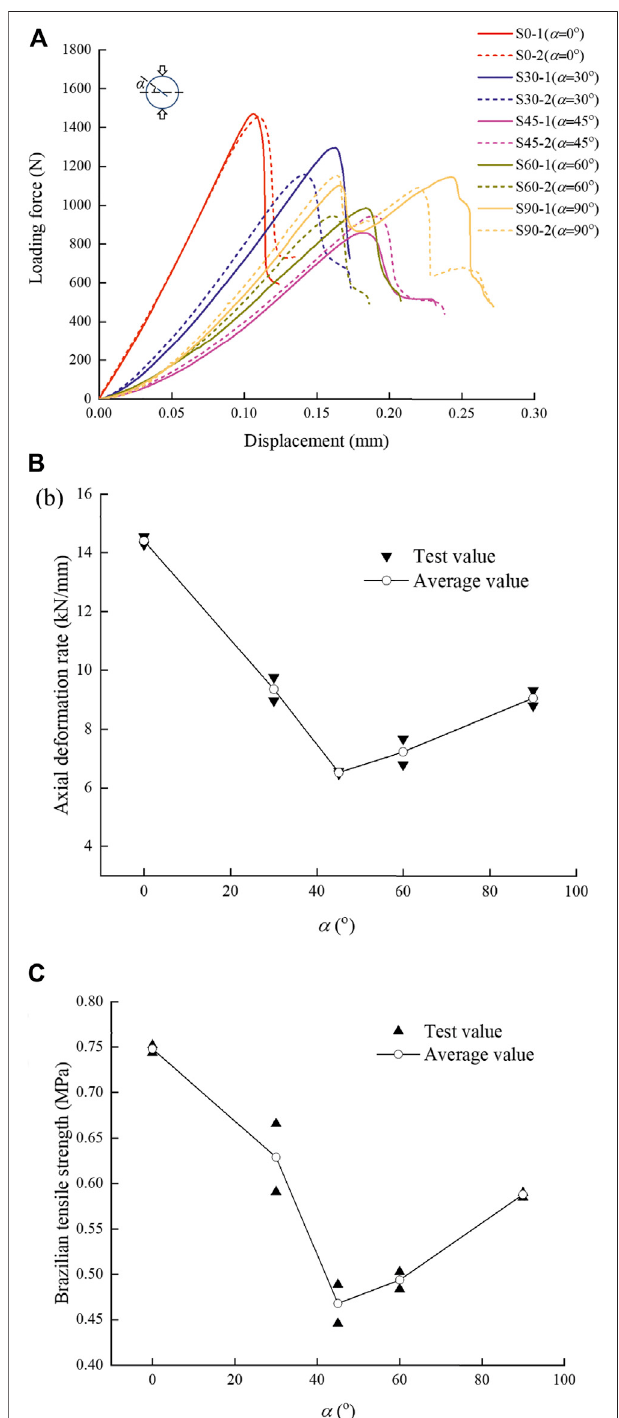
FIGURE 2 | (A) Loading force – displacement curves of sandstone specimens; (B) relationship between the axial deformation rate and the crack inclination; (C) relationship between the tension strength and the crack